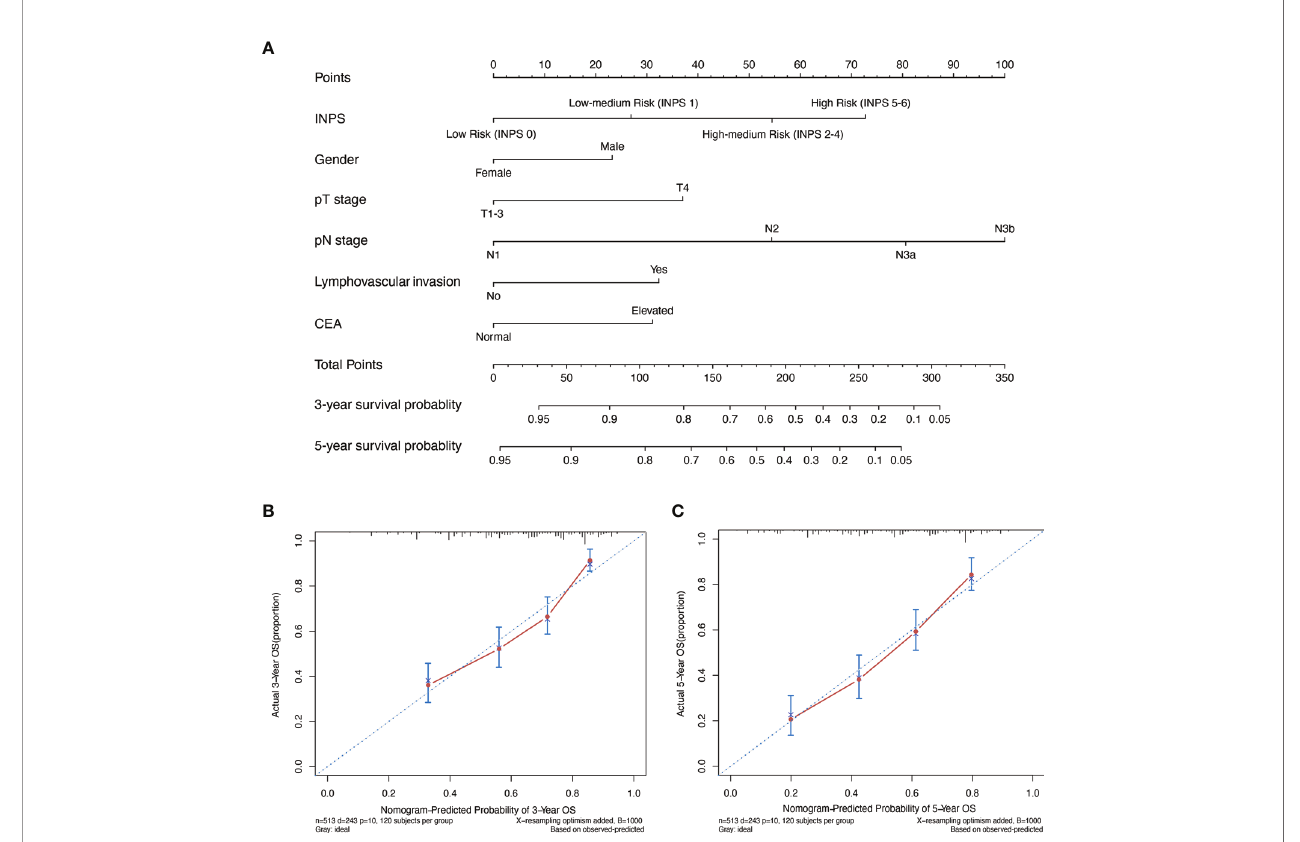
FIGURE 4 | A novel prognostic nomogram based on INPS for stage III GC patients. (A) The nomogram for predicting 3- and 5-year survival probability in stage III GC patients. Calibration plots of the nomogram for 3-year (B) and 5-year (C) survival probability using bootstraps with 1,000 resample. INPS, in fl ammatory-nutritional prognostic score; GC, gastric cancer; OS, overall survival; CEA, carcinoma embryonic